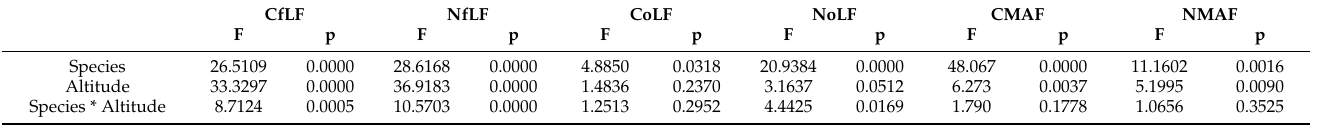
Table 5. Summary of GLM analysis for soil organic matter fractions.